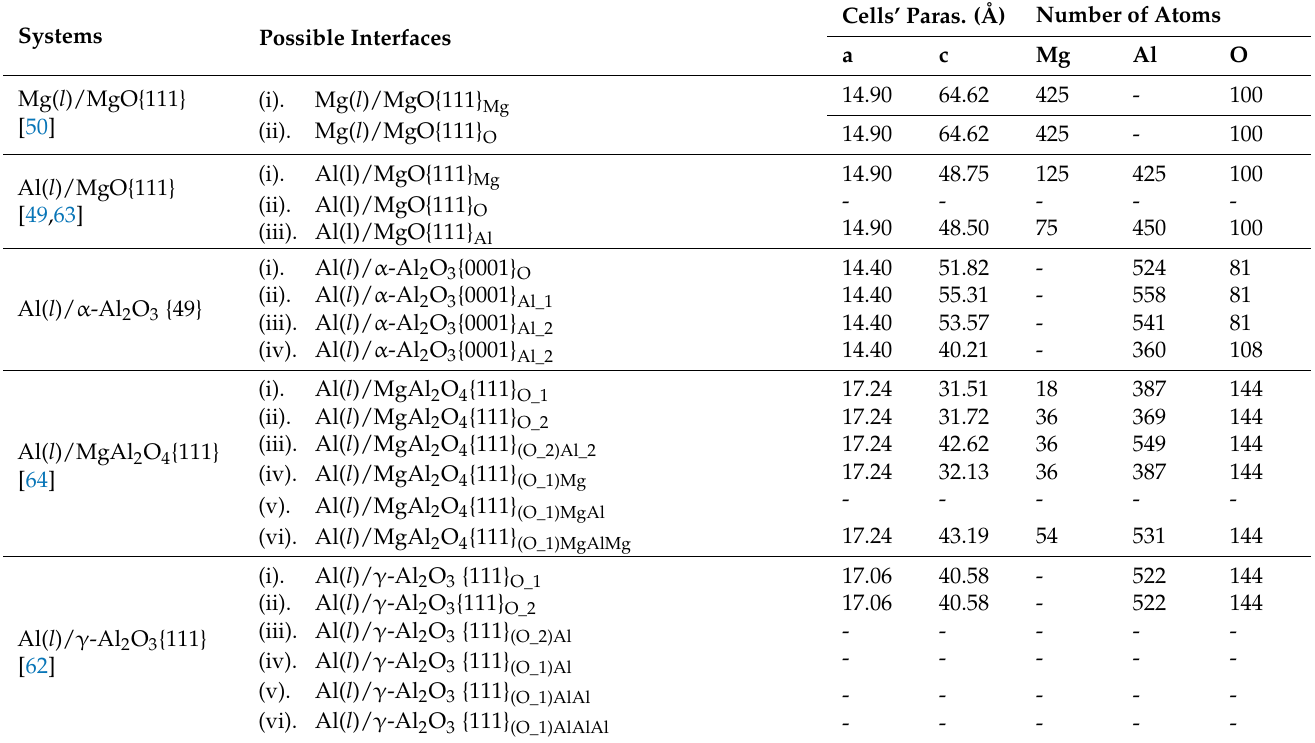
(Table 4). To study the evolutions of atomic ordering during the simulations and to assess the convergences of simulations, we also choose some dependent interfaces that are given in Table 4. Table 4. Inputs of the designed M( l )/oxide interfaces for AIMD simulations. All cells are hexagonal. Systems Possible